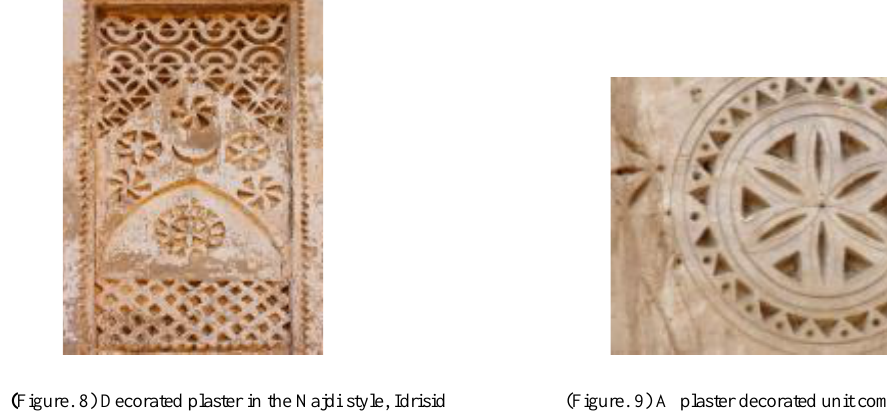
( Figure. 8) Decorated plaster in the Najdi style, Idrisid AD th 02AH/ th 14era